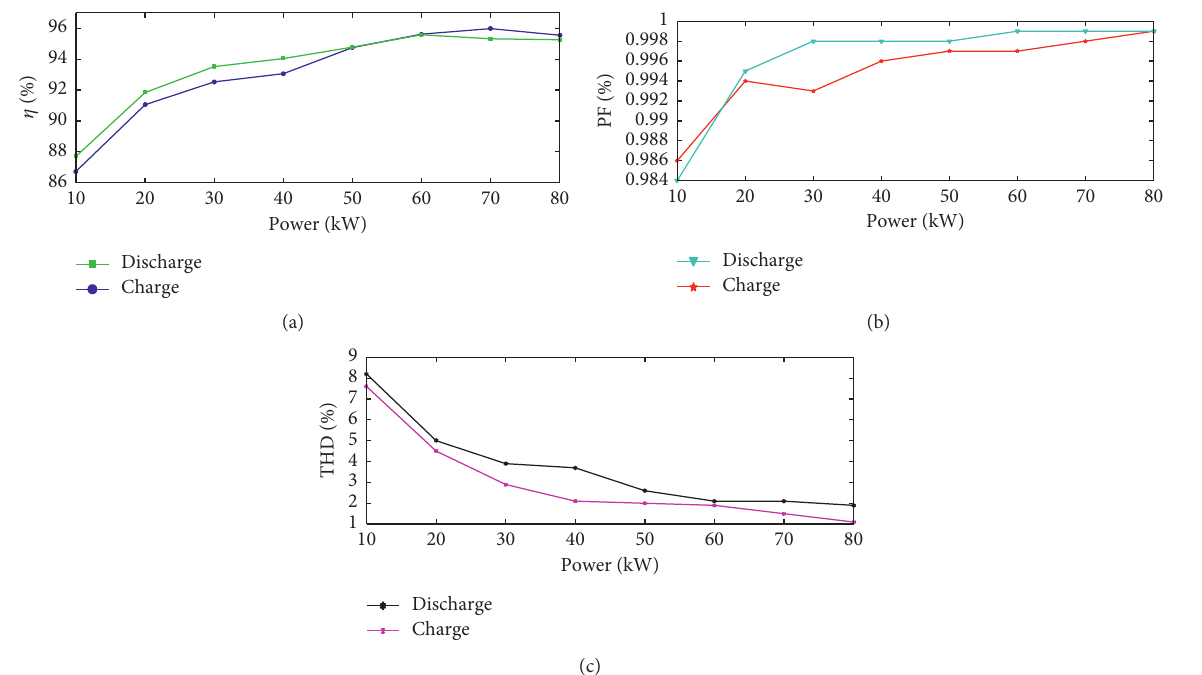
Figure 17: The curve of converter under different load conditions. (a) The efficiency curve. (b) The power factor curve. (c) THD